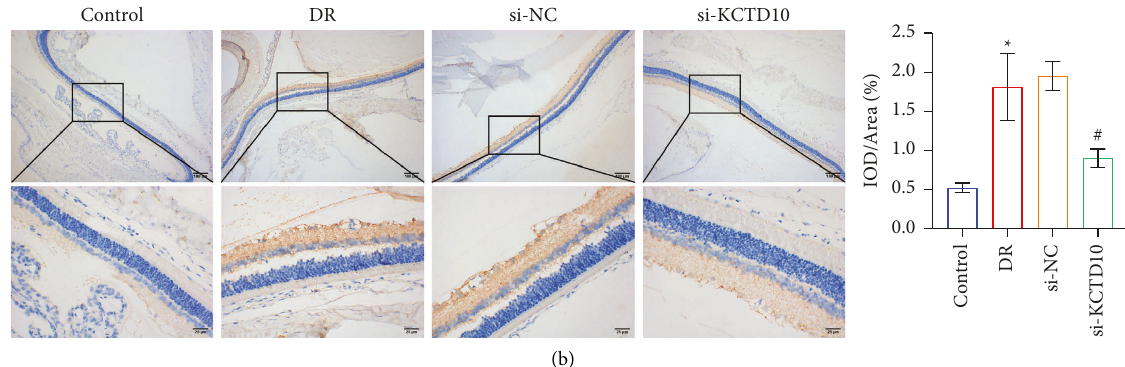
Figure 5: Distribution of KCTD10 and VEGF in retinal tissue of DR animal. (a), (b) The expression of KCTD10 and VEGF in the retinal tissue of DR rats was identified by immunohistochemical assay. ∗ P < 0 . 05 versus the control group. # P < 0 . 05, versus the si-KCTD10